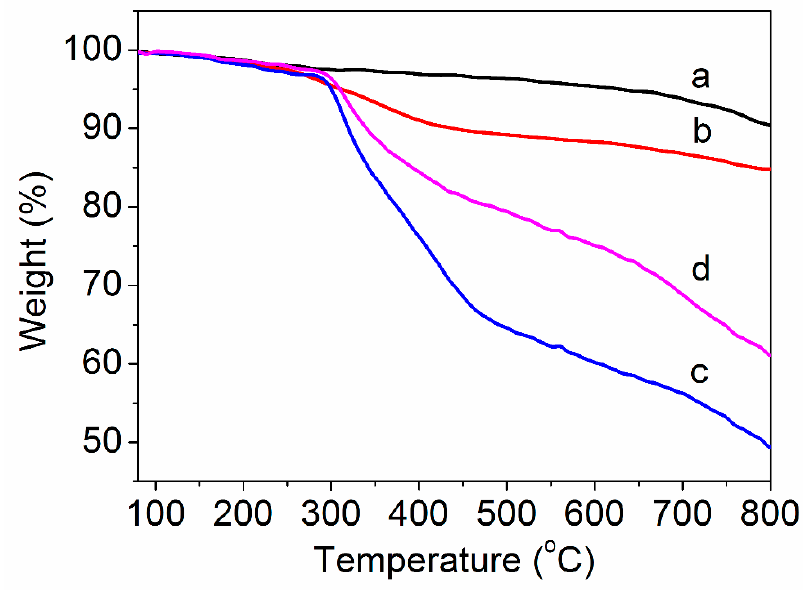
Figure 4. TG curves of ( a ) purified MWCNTs, ( b ) amino ‐ MWCNTs, ( c ) PAN polymer and ( d ) PAN grafted amino ‐ MWCNT nanocomposites.